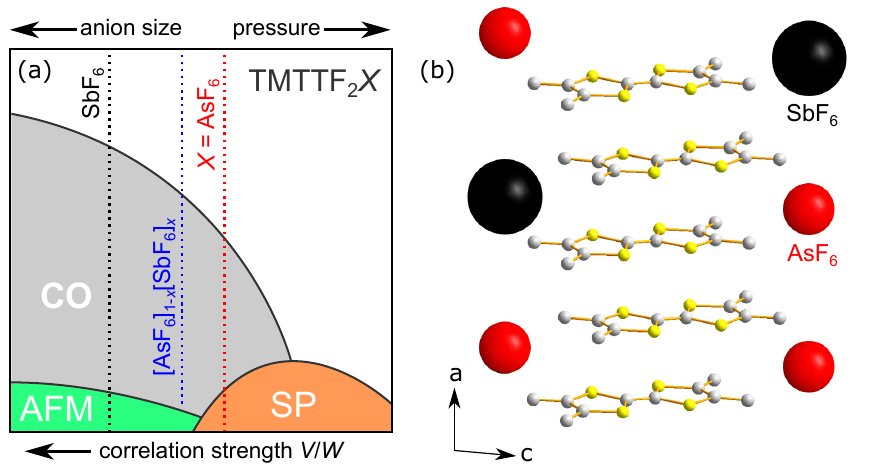
Figure 1. (Color online) ( a ) (TMTTF) 2 X with X = SbF 6 exhibits larger electronic correlation strength V / W as the molecules are separated further apart than for X = AsF 6 . Modifying the intersite spacing via physical pressure or chemical substitution allows tuning through charge-ordered (CO), antiferromagnetic (AFM), and spin-Peierls (SP) states in the phase diagram. ( b ) Partial substitution of AsF 6 anions (red) with larger SbF 6 (black) in (TMTTF) 2 [AsF 6 ] 1 − x [SbF 6 ] x yields a position between the two parent compounds, indicated by the dotted blue line in ( a